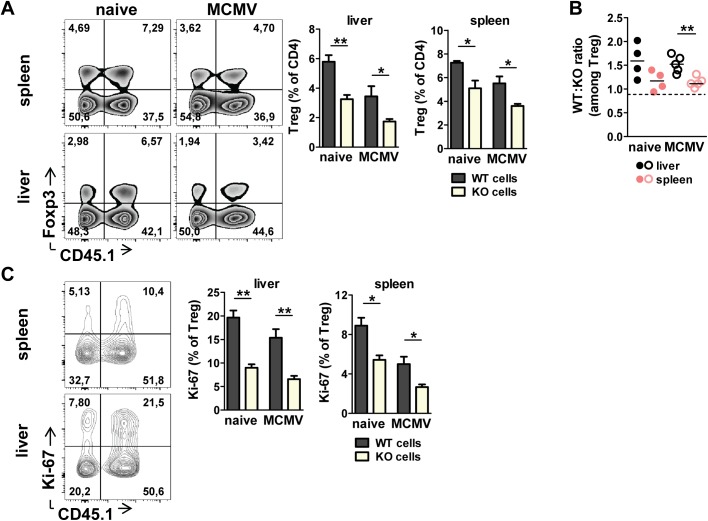
Intrinsic requirement for ST2 expression in Treg cells.Mixed bone marrow chimeras were generated by irradiation of C57BL/6 CD45.1+CD45.2+ mice followed by i.v. injection of 1:1 mixture of wild-type (WT; CD45.1+) and knockout (ST2-/-; CD45.2+) bone marrow cells. After reconstitution, mixed chimeras were infected with 2x105 PFU of Δm157 MCMV and analyzed on day 7 p.i. (A) Percentage of donor WT and KO Treg cells is shown. (B) The ratio between WT and KO Treg cells is shown. Dotted line represents initial ratio of transferred bone marrow cells. (C) Percentage of Ki-67 expression by donor Treg cells is shown. Data are shown as mean ± SEM of n = 4–5 mice per group from one representative experiment out of two. *p <0.05 and **p<0.01 from two tailed, unpaired Student’s t-test.